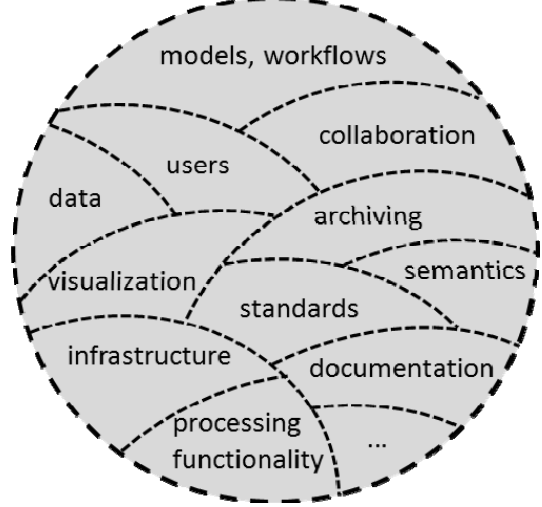
Figure 1. E-Science environments: a conglomerate of